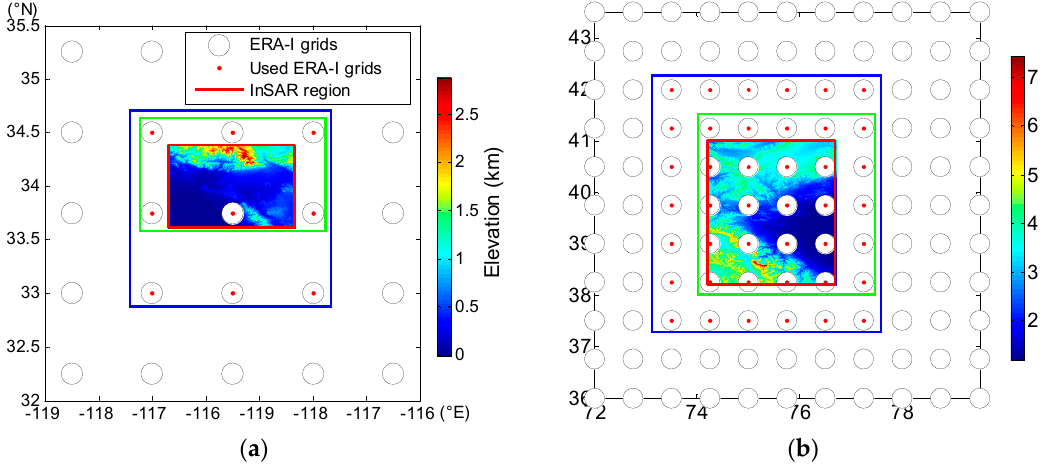
Figure 2. The distribution of ERA-I grid points for: ( a ) California; and ( b ) Tianshan. Black circular markers indicate the location of the ERA-I grid points at ~75 km spatial resolution. The red points within the circular markers are the points used for the ERA-I method. Red solid lines outline our test regions. The background is the SRTM topography. The points within the green rectangles were used for our PLE method.